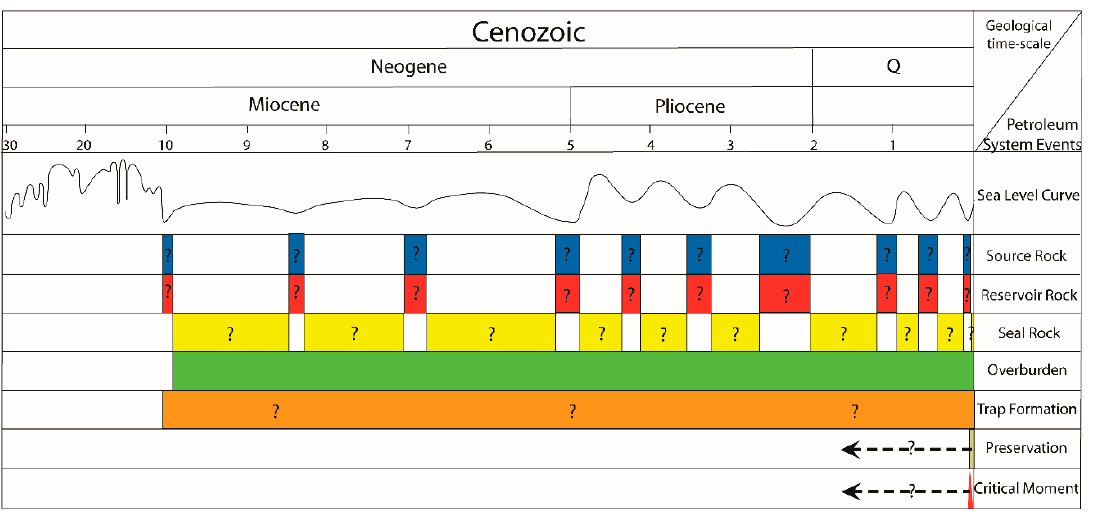
Figure 15. Event chart of the speculative Neogene/Quaternary–Neogene/Quaternary Petroleum System (?). Question marks indicate uncertainties. The sea level curve is from Haq et al. [56].